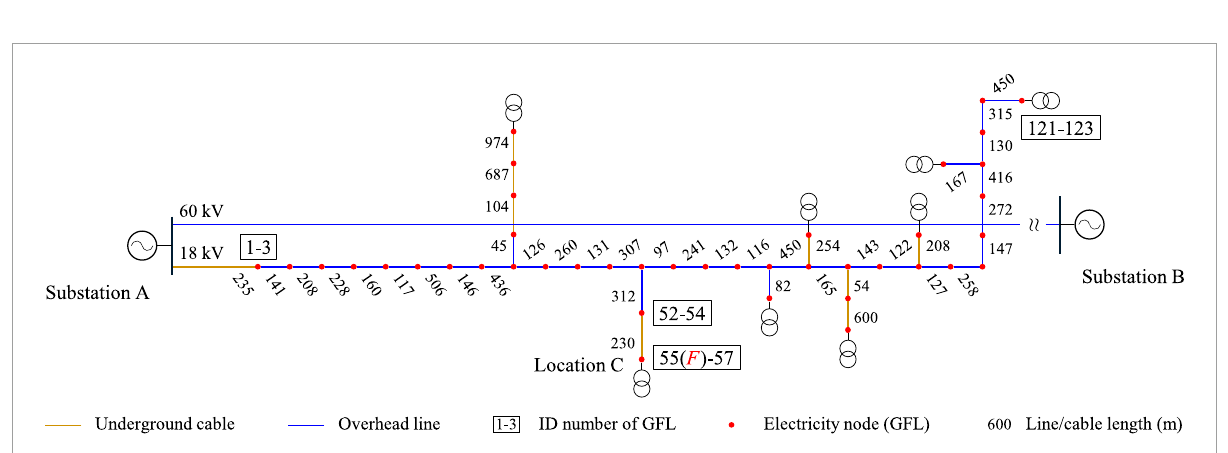
FIGURE 5 Schematic description of the pilot test set-up configured using a radial MV distribution feeder [adopted from (Wang et al. (2020b)]. The pilot network consisted of 11.9-km long double-circuit lines (overhead lines) operating at 18/60 kV and eight 18-kV three-phase laterals (overhead lines, underground cables, or mixed configuration). The MV side of the primary substation A served as the single observation point. The assumed fault location was the line-cable mixed lateral terminal indicated as Location